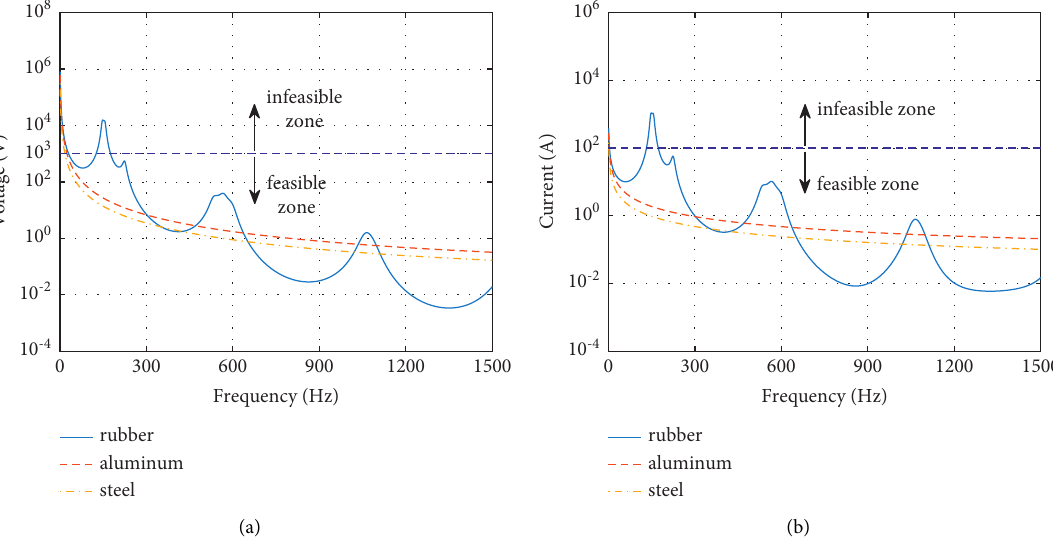
Figure 19: Voltages and currents of PSPS with different passive materials. (a) Required voltages of the piezoelectric stacks under active control. (b) Required currents of the piezoelectric stacks under active control.